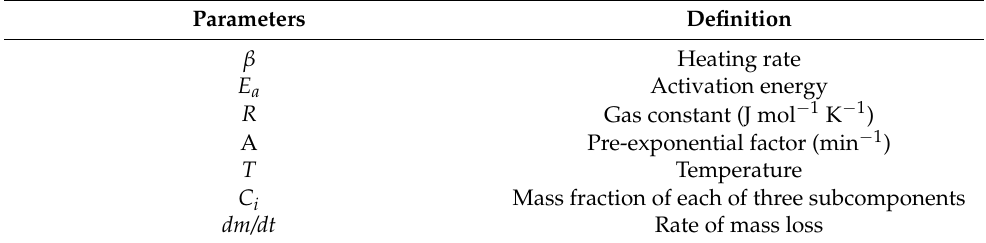
Table 2. Parameters of the used models